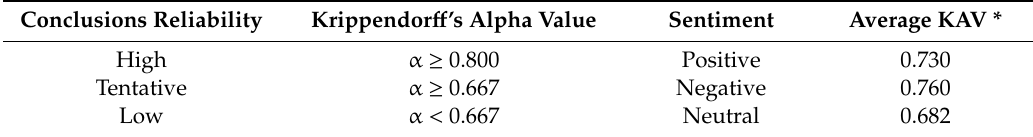
Table 2. Sentiment analysis and Krippendor ff ’s alpha value